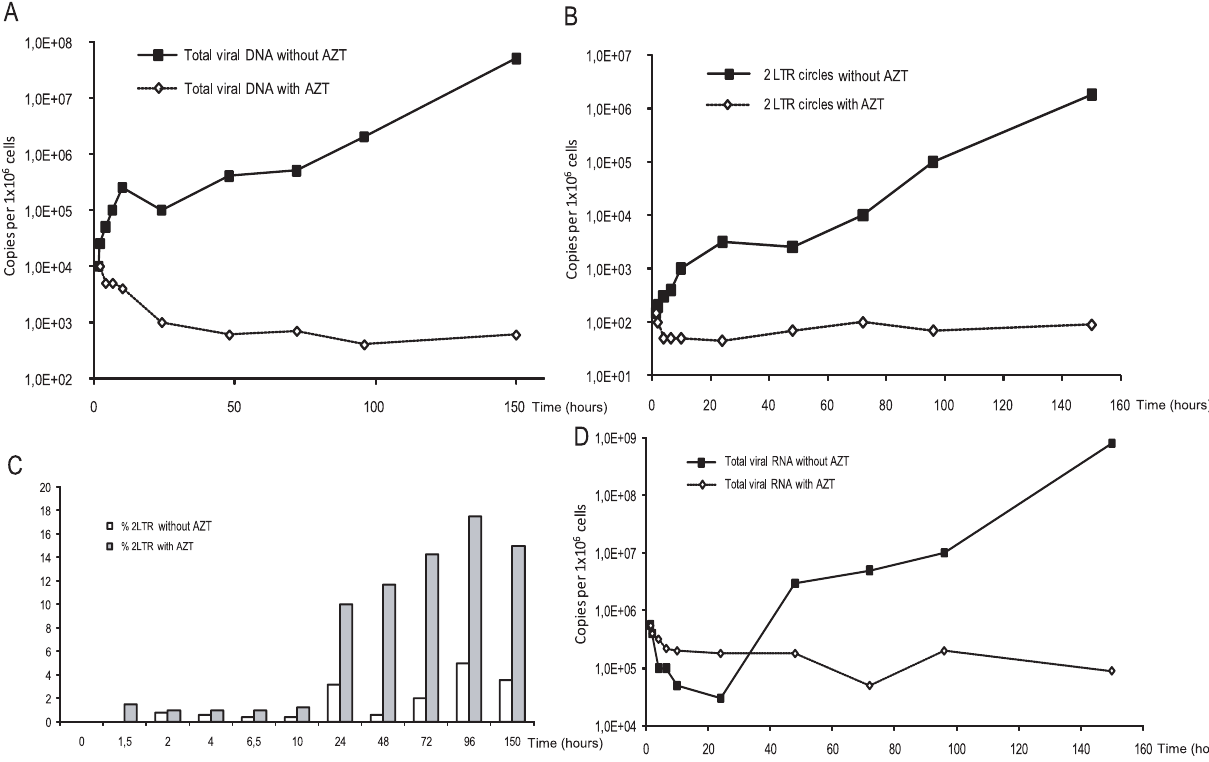
Figure 3. Kinetic analysis of PFV RNA and DNA synthesis over 6 days post-infection. U373-MG cells were infected in the presence or absence of AZT. Viral DNA ( A ), 2-LTR circles ( B ), viral RNA ( C ) were monitored by real-time PCR and RT-PCR. The percentage of 2-LTR circles over linear viral DNA is represented ( C ).